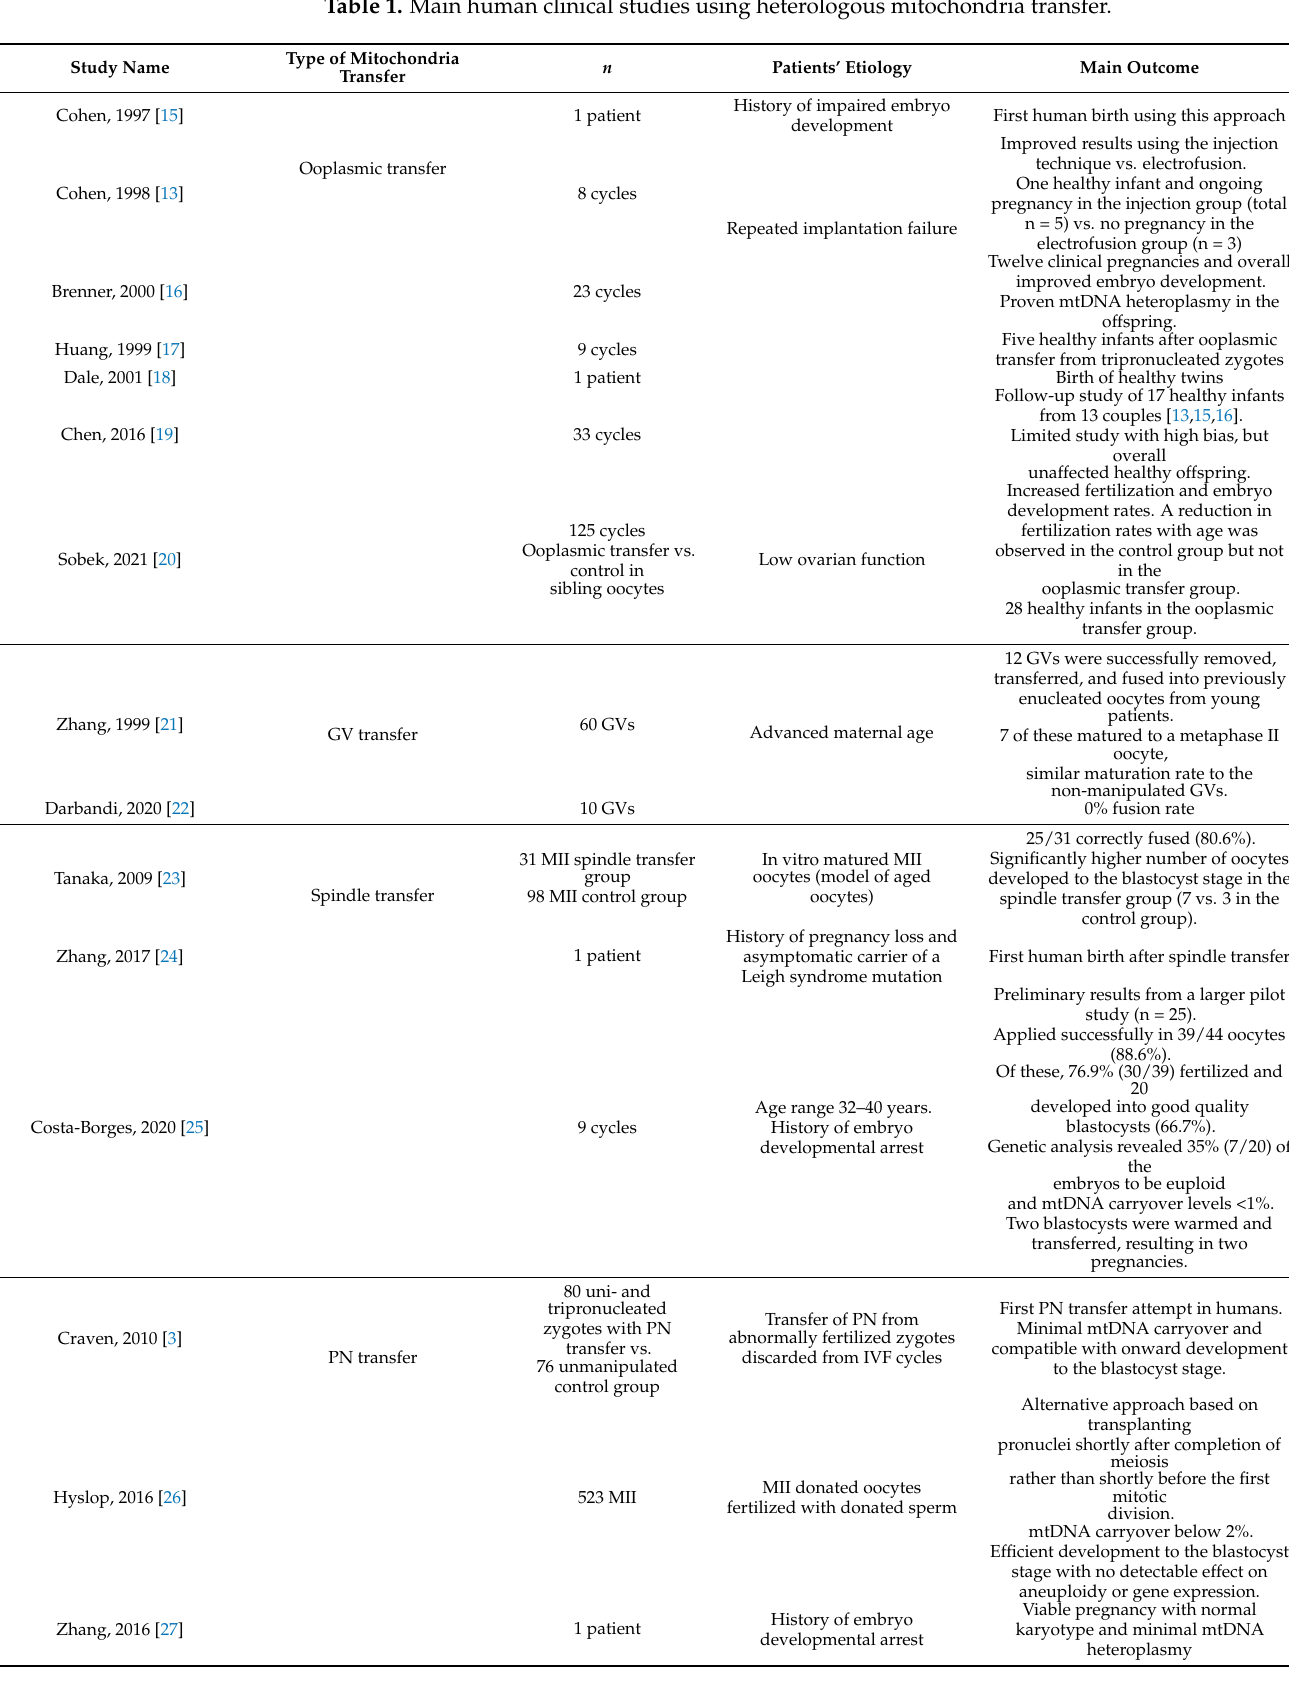
Table 1. Main human clinical studies using heterologous mitochondria